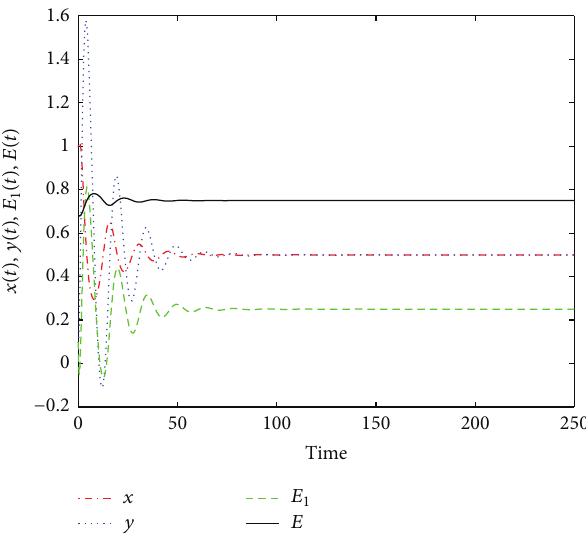
Figure 1: The dynamic responses of (45) near equilibrium before control.